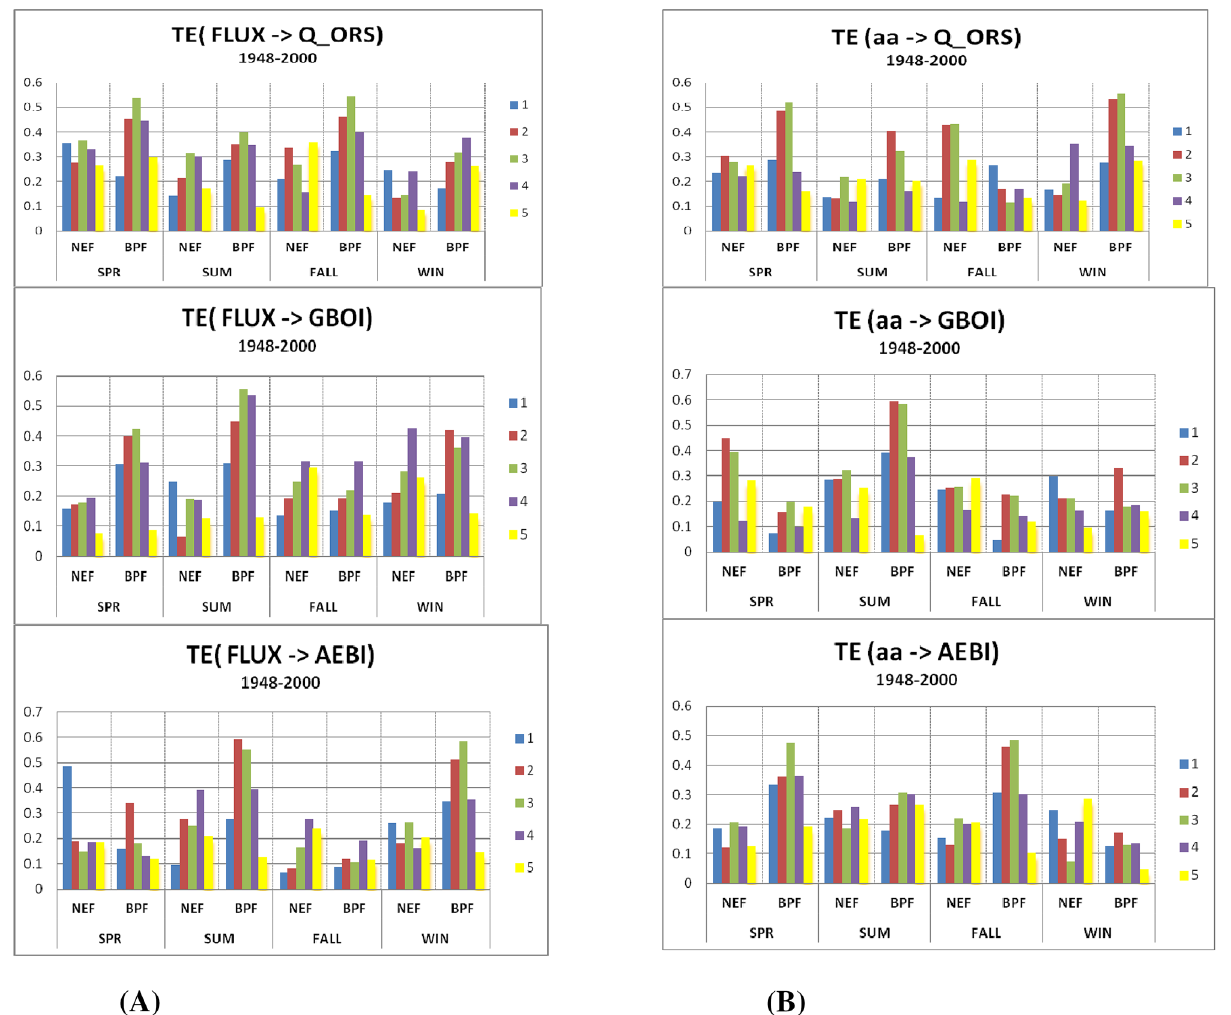
Figure 3. ( A ) The transfer entropy (TE) from solar flux to Q_ORS, GBOI and AEBI, with lags from 1 to 5 years, in case of unfiltered (NEF) and filtered (BPF) time series, for each season in the Period I. ( B ) The TE from aa geomagnetic index to Q_ORS, GBOI and AEBI, with lags from 1 to 5 years, in case of NEF and BPF time series, for each season in the Period the two initial series have a positive correlation, the arrows indicate that the first series, which corresponds to the solar flux, drives the second AEBI series, with a quarter of a period meaning approximately 3 years. Figure 4B,C show WTCs for 2- and 3-year lags, respectively, between the solar flux and the blocking indices. These last figures show that the areas with significant coherence are similar, with a slight intensity of coherence if the lag between the solar flux and AEBI is 3 years. Considering the results obtained by Mares et al. (2016) 25 , approximately 2–3 years after the maximum (mini- mum) solar activity, the atmospheric circulation of the blocking type is enhanced (weakened) during winter over the Atlantic-European region. This result is also confirmed by composite maps at 500 hPa for the winter season, and when high solar flux (Fig. 5A) and low solar flux (Fig. 5A) are observed, the geopotential field that lags the solar flux by 3 years is considered. Here, we define high-flux cases as years in which the standardized values of the solar flux are greater than 1 and low-flux cases as years in which the standardized flux values were less than − 1. In the first case (Fig. 5A), the composite map defines a positive blocking index, and in the second case (Fig. 5B), the blocking index is negative. The advantages of applying nonlinear and nonstationary techniques are also highlighted by comparing the results obtained here with those obtained by applying the analysis of linear correlations. For example, Fig. S3a in the Supplementary Information shows that for the unfiltered and filtered data, the Pearson correlation coefficient between the solar flux and the AEBI does not show results with different statistical significance because the con- nection between the two variables is nonstationary and nonlinear. The graph in Fig. S3b indicates good coher- ence between the solar flux and AEBI for the period 1965–1985, which is consistent with the WTC in Fig. 4B.